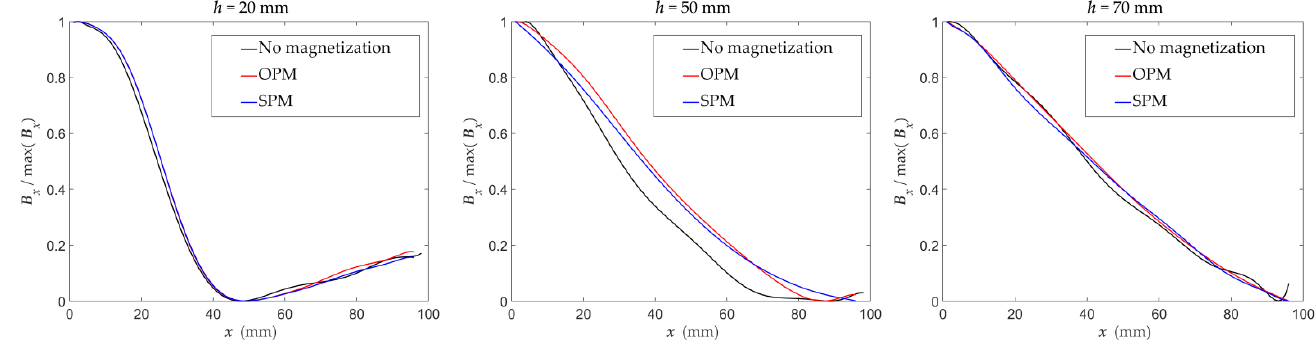
Figure 19. Graphs of the normalized maximum values of the magnetic field components as a func- tion of the concrete cover thickness h obtained for various magnetization methods.